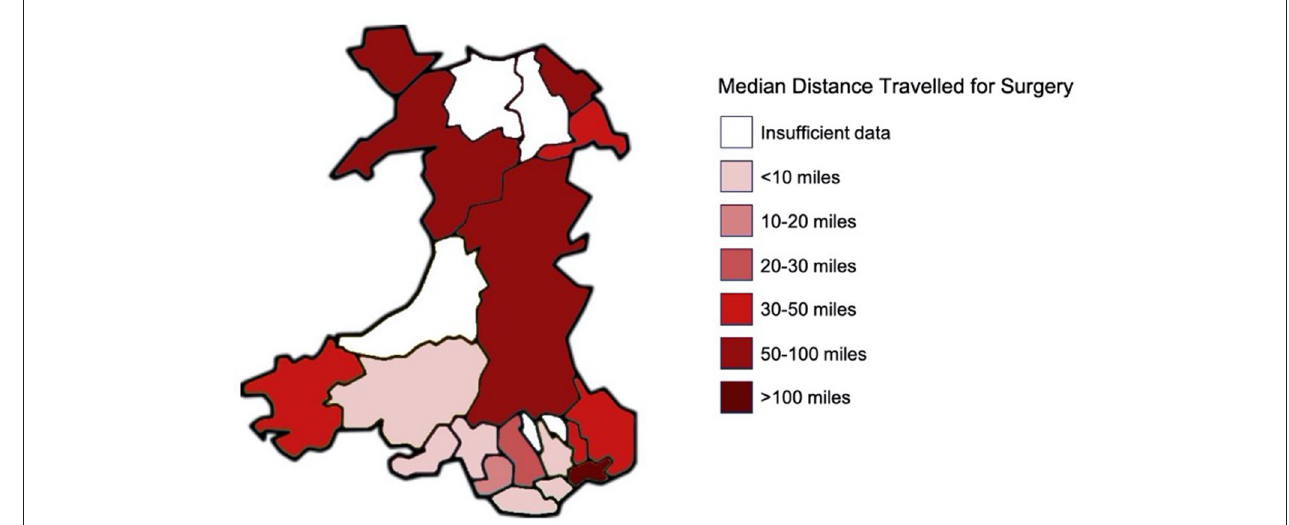
FIGURE 4 | Heat map to demonstrate the regional variability in geodesic distance traveled for surgery in